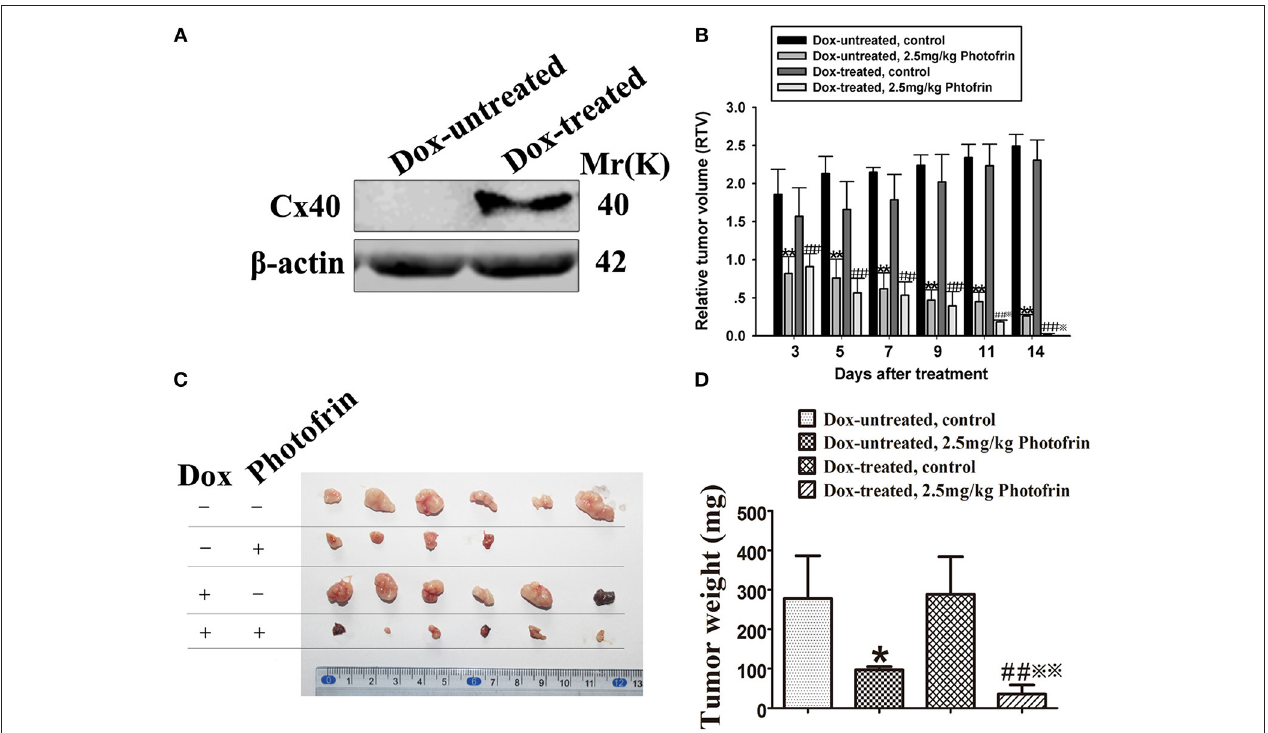
FIGURE 3 | Cx40-formed channels increase the sensitivity of tumor xenografts to Photofrin-mediated PDT. (A) Cx40 expression induced by Dox in the xenograft tumors was detected by Western blot; (B) The presence of Cx40-composed channels decreases the RTV of xenografts after PDT; (C,D) Xenografts’ weights after PDT. For (B–D) data points are mean ± SD from 4 to 6 independent samples. One-way ANOVA was used to assess statistically significant differences between groups.* P < 0.05, ** P < 0.01, significantly different from Dox-untreated group; ## P < 0.01, significantly different from Dox-untreated group; ※ P < 0.05, ※※ P < 0.01, significantly different from 2.5 mg/kg Photofrin group (Dox-untreated).